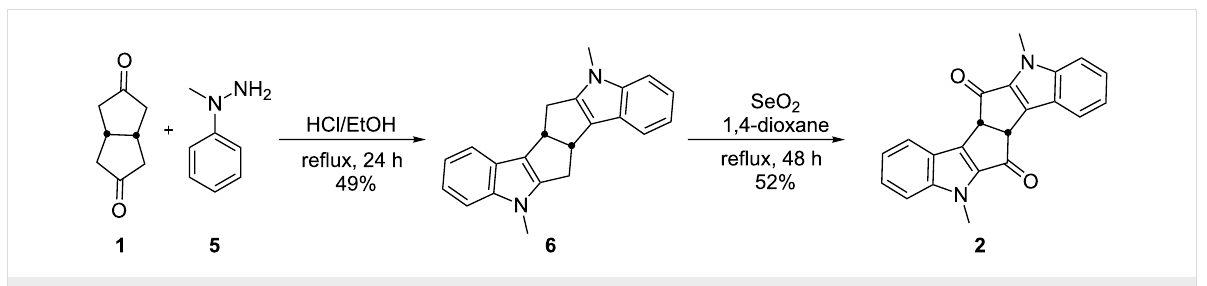
Scheme 1: Preparation of diindole dione 2